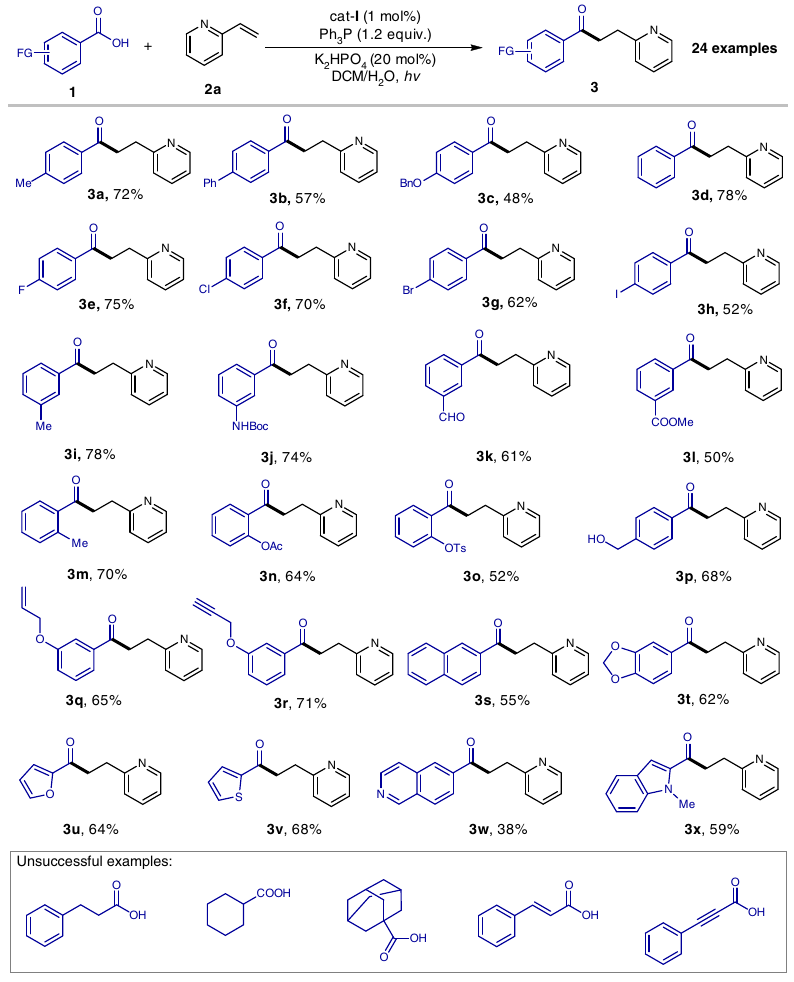
Fig. 2 Aromatic carboxylic acid scope. Bn benzyl; Boc tert -butoxycarbonyl; Ts para